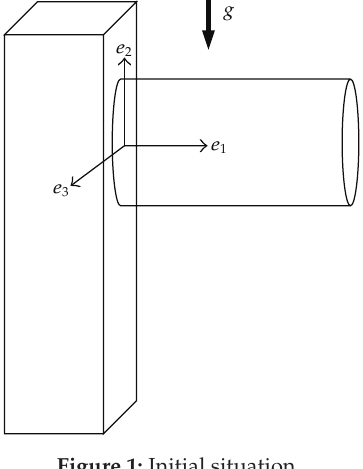
Figure 1: Initial